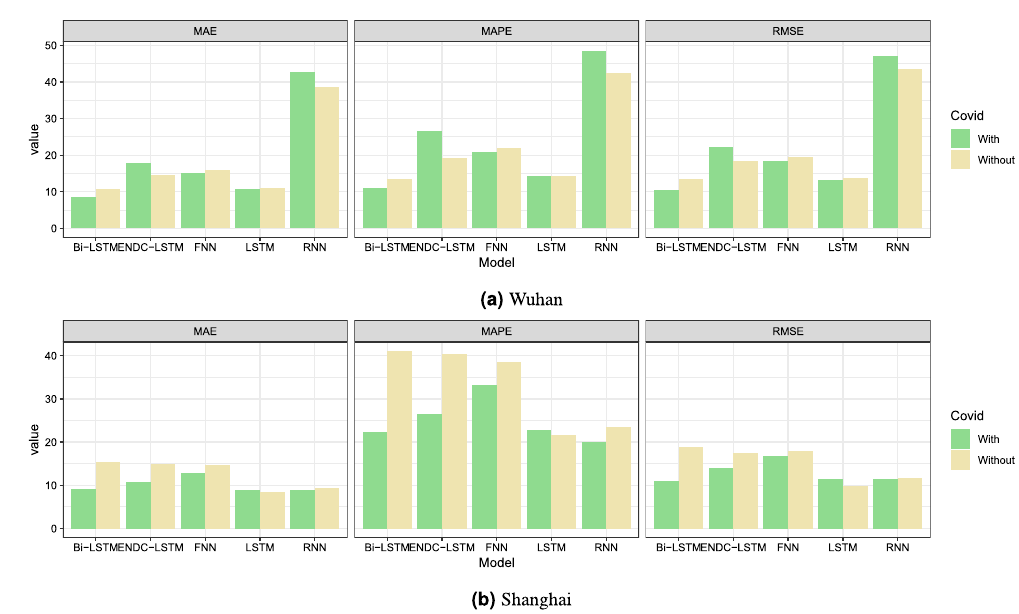
Figure 7. The impacts of COVID-19 on the different model for t + 1